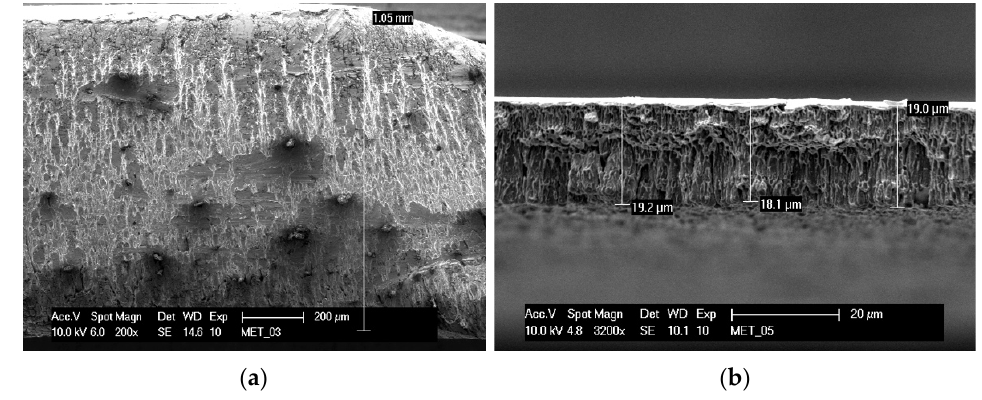
Figure 3. The cross-section SEM analysis of Cu deposit, produced with MS technique: columnar growth at the beginning of the layer ( a ) and changing from columnar to nucleus growth after the 100 µm ( b ).